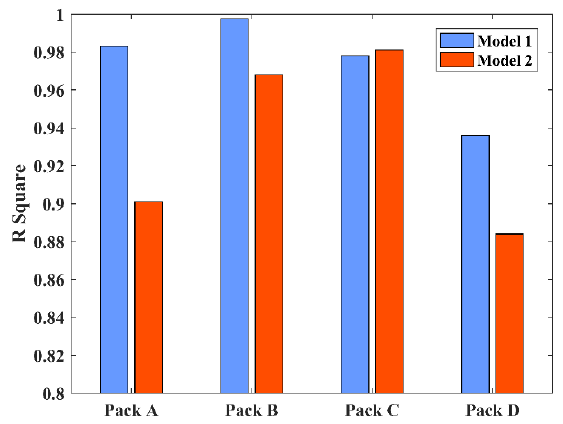
Figure 5. The regression coefficients of Model 1 and Model 2.